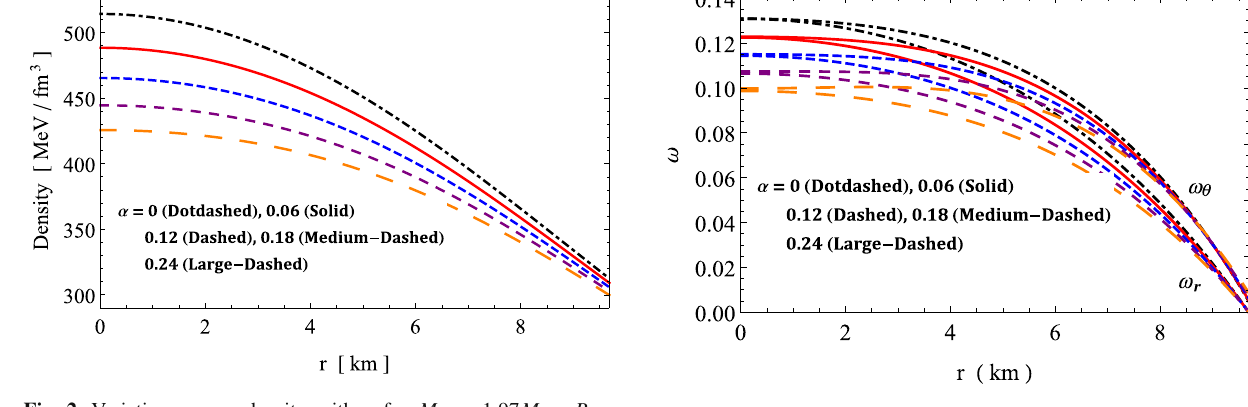
Fig. 5 Variation equation of state parameter with r for M =